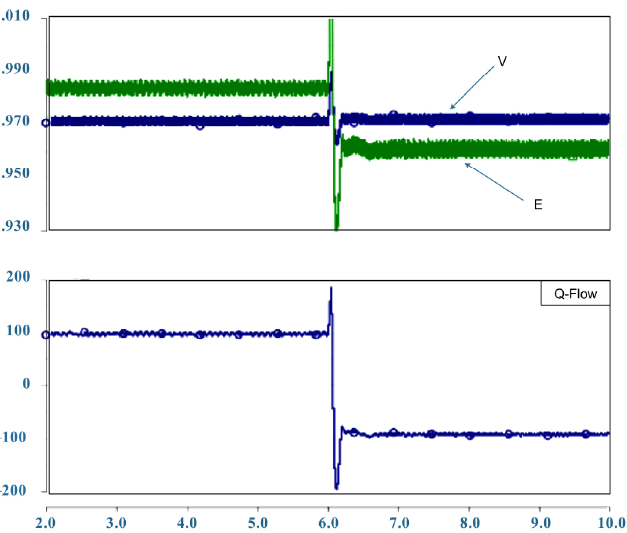
Figure 2. Reactive power generation is based on the voltage difference between the EV system and the grid.